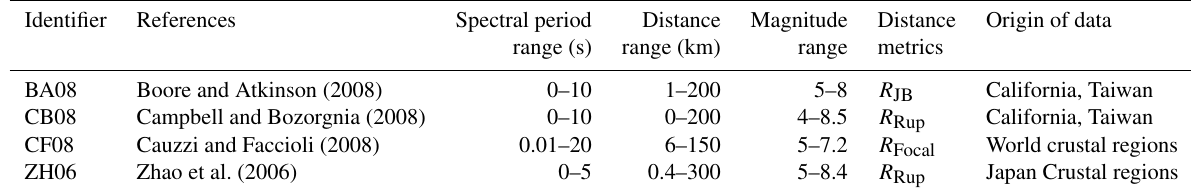
Table 3. GMPEs considered in this